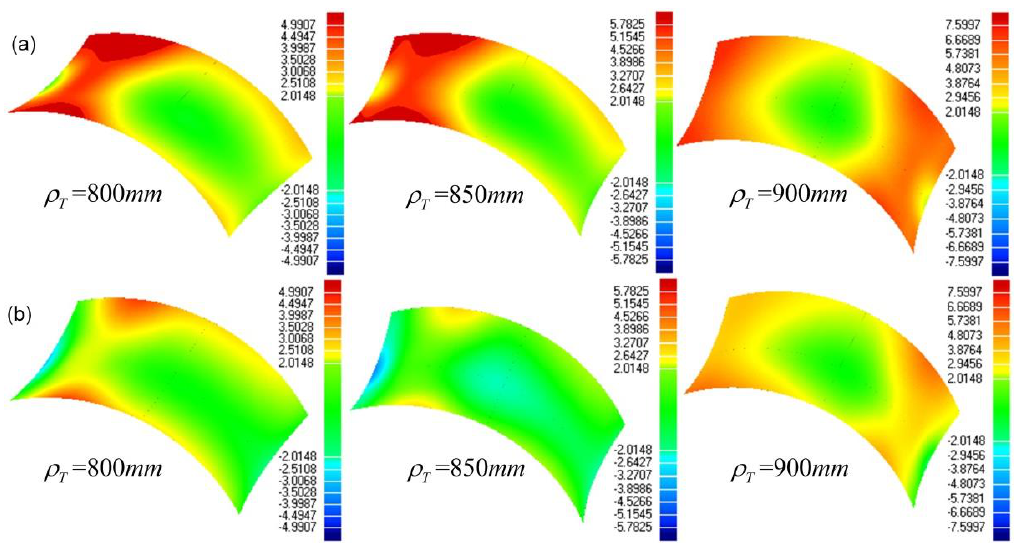
Figure 10. Error nephograms under different transversal radii of saddle surfaces: ( a ) before modification; ( b ) after modification.